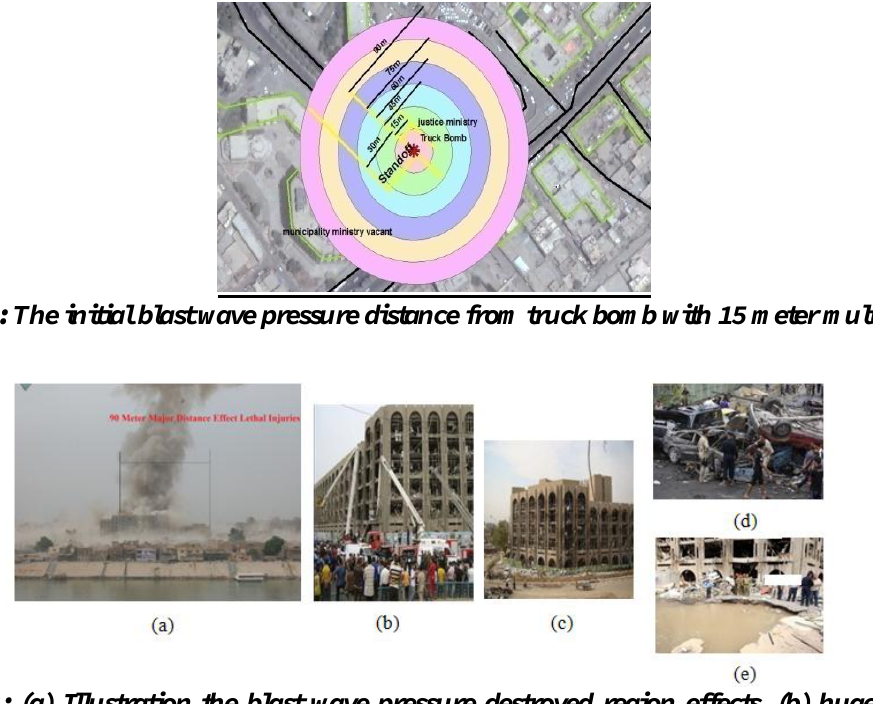
Fig. 12: (a) Illustration the blast wave pressure destroyed region effects, (b) huge initial destroy the building side 1, (c) secondary destroy the building side 2, (d) adjacent cars of truck bomb pressure destroy, (e) strength of truck bomb occur crater about 10m diameter and 1m in